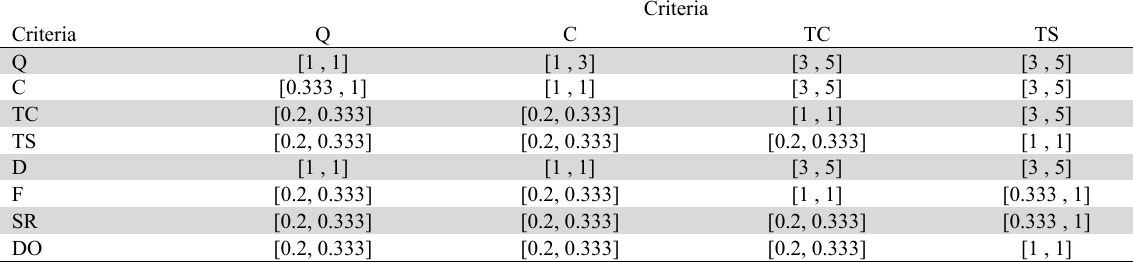
Grey Constructed Comparison Matrix